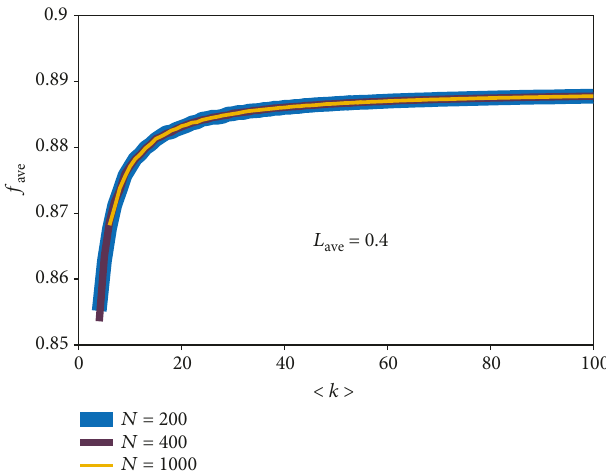
Figure 3: The average infected degree for di ff erent values of < k > in di ff erent network.